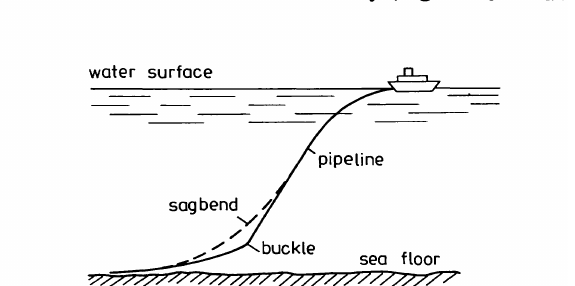
FIGURE 7 Initiating of a buckle during an installa tion of an offshore